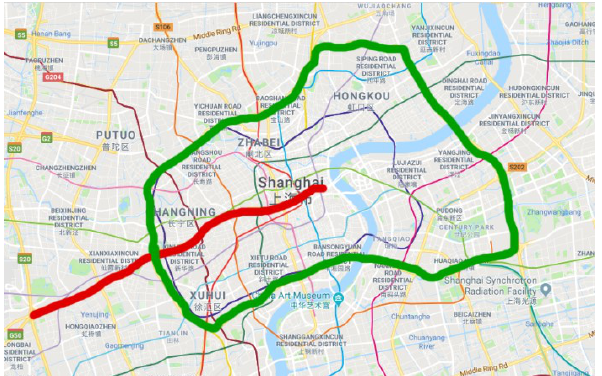
Figure 6. Marking of two elevated highways. Red and green bold lines mark Yan’an elevated highway and Neihuan elevated highway,